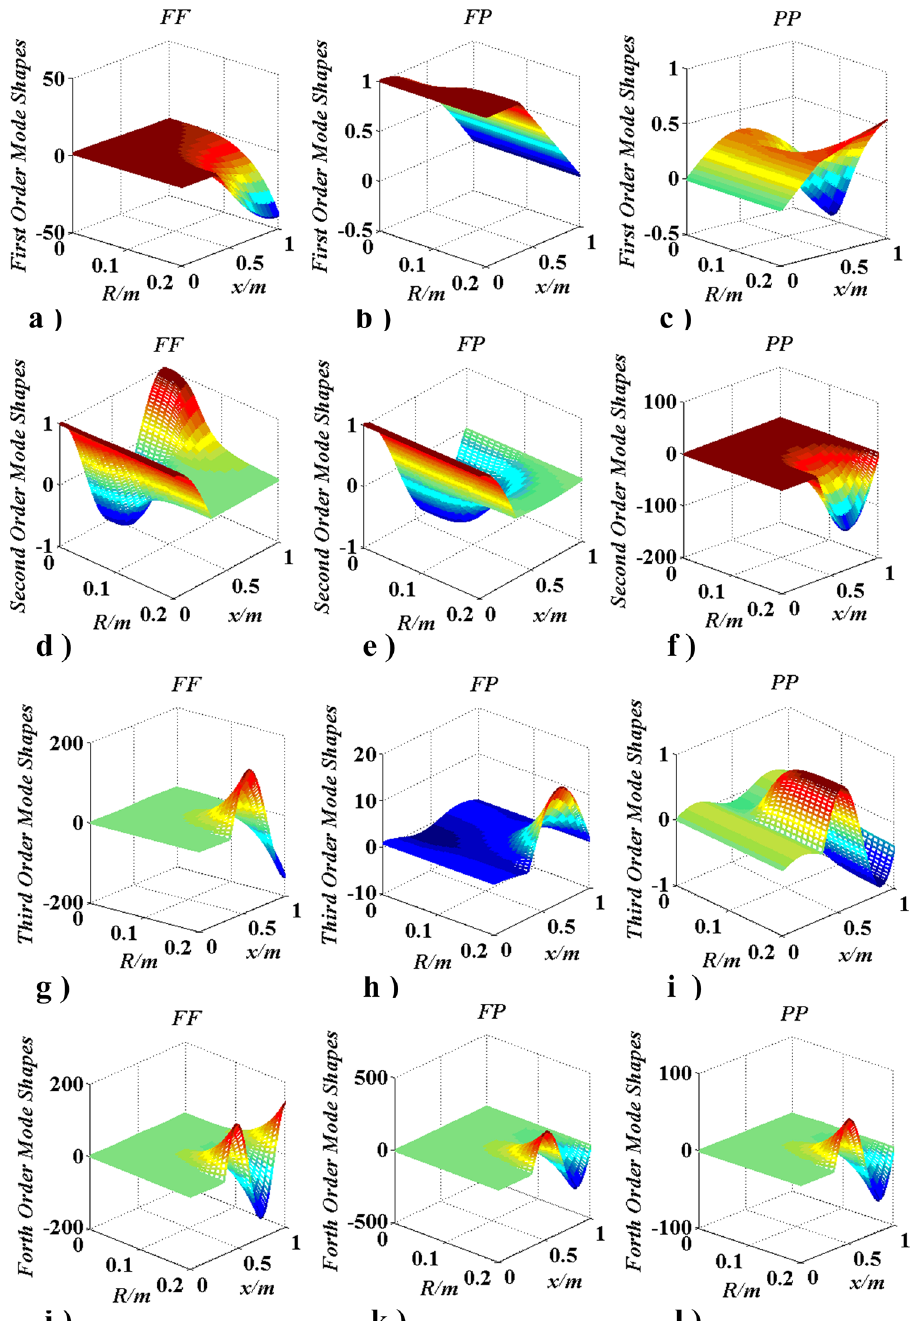
Figure 20. Changes of mode shapes with R ( J m ) and boundary